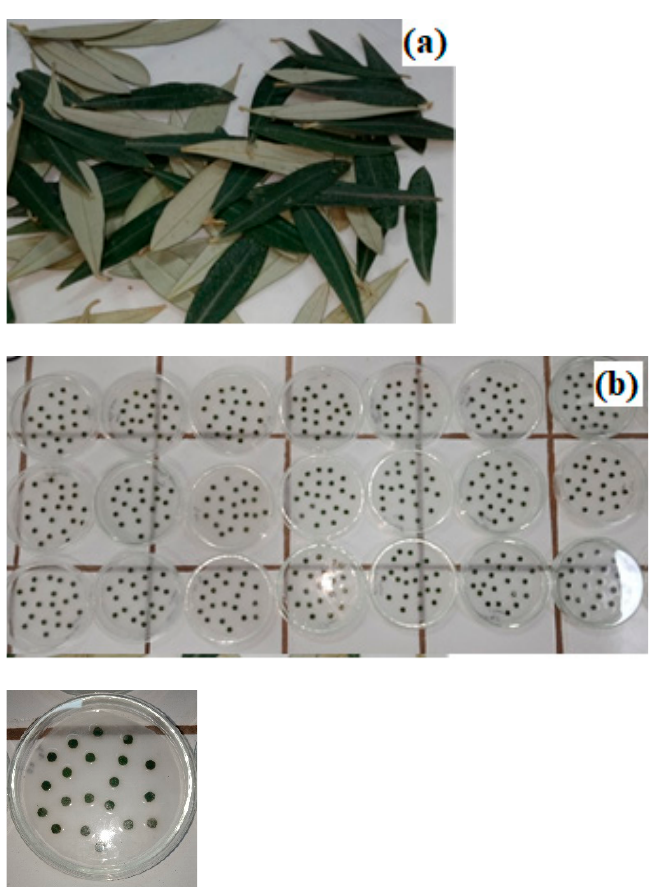
Figure 2. Detached leaves of the olive tree “Picholine Marocaine” ( a ); Leaf discs (5 mm in diameter) placed in the Petri dishes containing saccharide solutions ( b ).